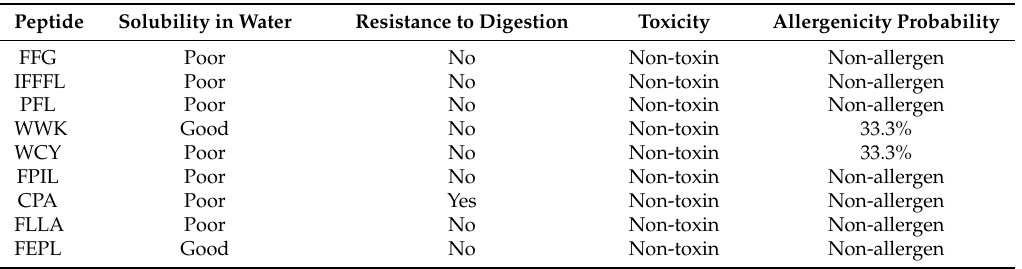
Table 4. Selected peptides and predicted solubility, resistance to digestion, toxicity, and allergenicity for chosen oat peptides.